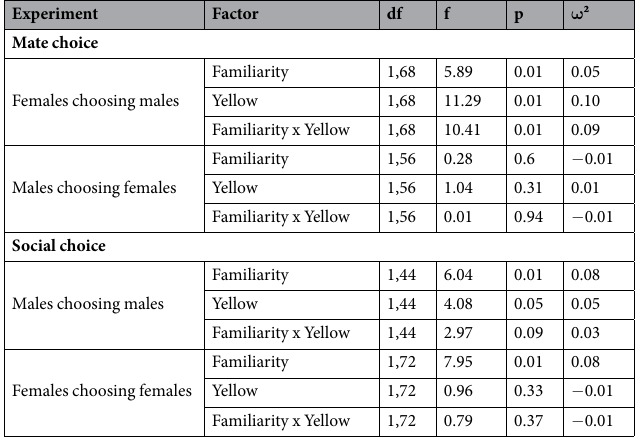
Table 1. Results of ANOVA comparing preference of experimental birds, white-eyed bulbuls ( Pycnonotus xanthopygos ), for familiarity and ornament colouration (increased or decreased yellow ventral plumage colour) in sexual and social context, using four different